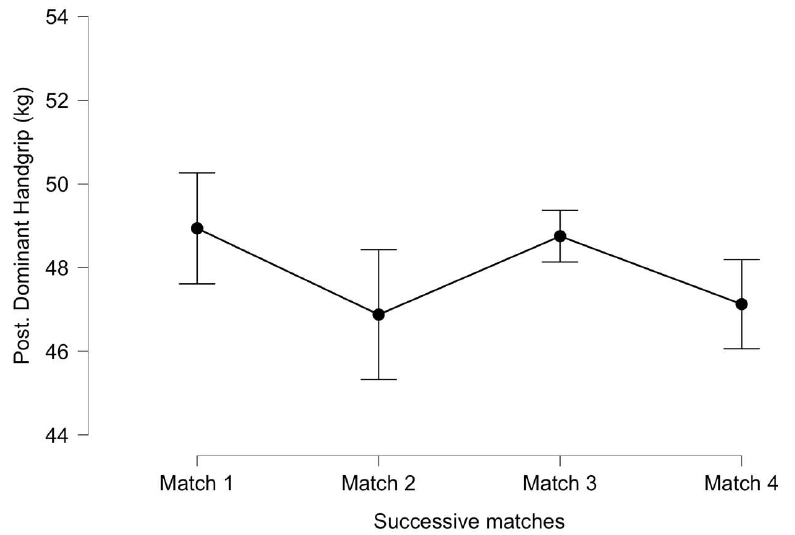
Figure 4. Post-match dominant handgrip strength throughout successive matches. Lines denote the mean (95 CI).